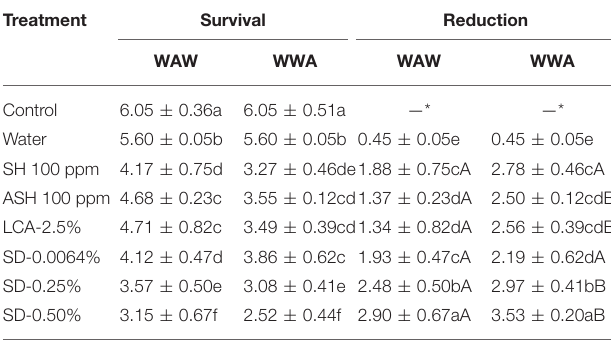
— * Indicates reduction data are not available. Mean values with different lowercase letters within a column are significantly different ( P < 0.05) . Mean values with different capital letters within a row are significantly different ( P < 0.05)